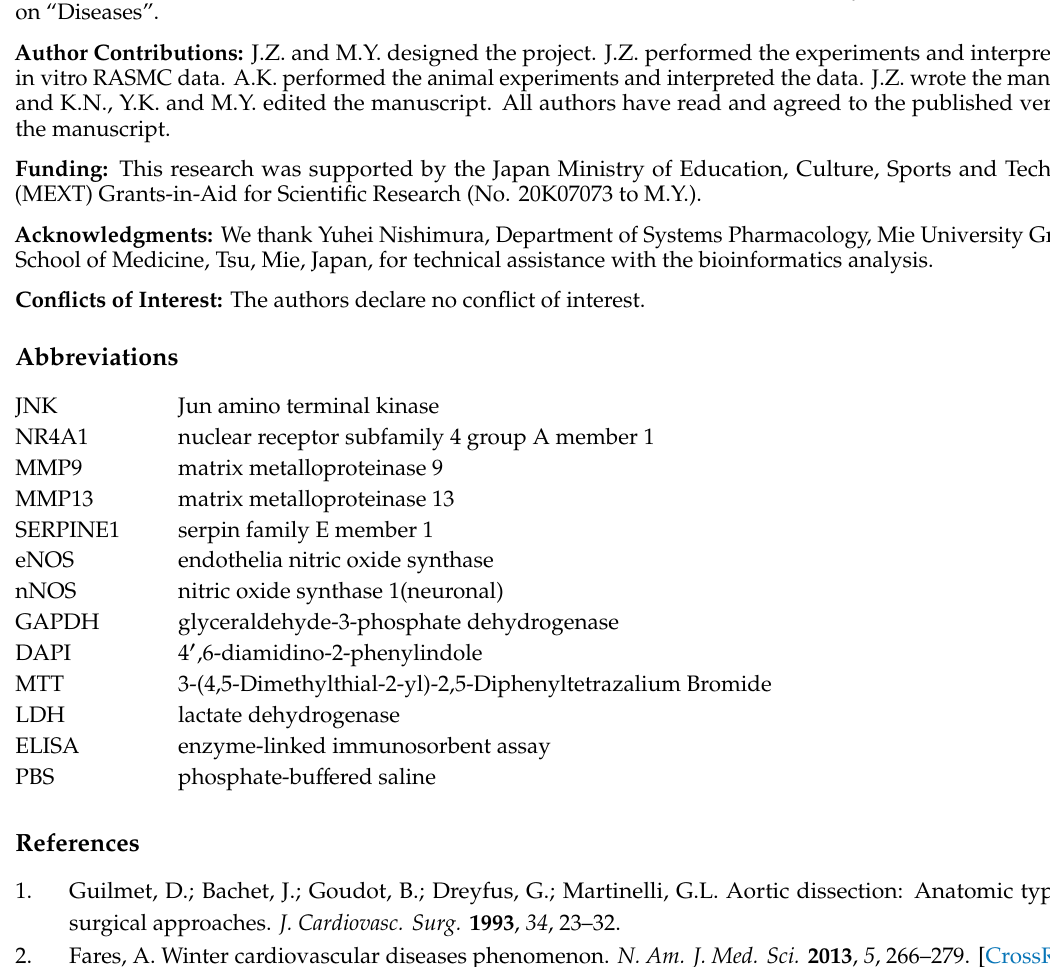
s1. Figure S1: Uncropped pictures of immunohistochemical analysis, Figure S2: Uncropped pictures of immunoblotting, Figure S3: Induction of eNOS in RASMCs subjected to CMS, Table S1: Cell processes significantly related to the 91 DEGs in RASMC treated with CMS, Table S2: Enrichment analysis of the DEGs focusing on